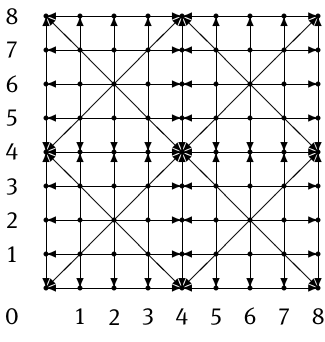
Figure 1: The path set B 2 ⊆ P 2 ( H 2 )